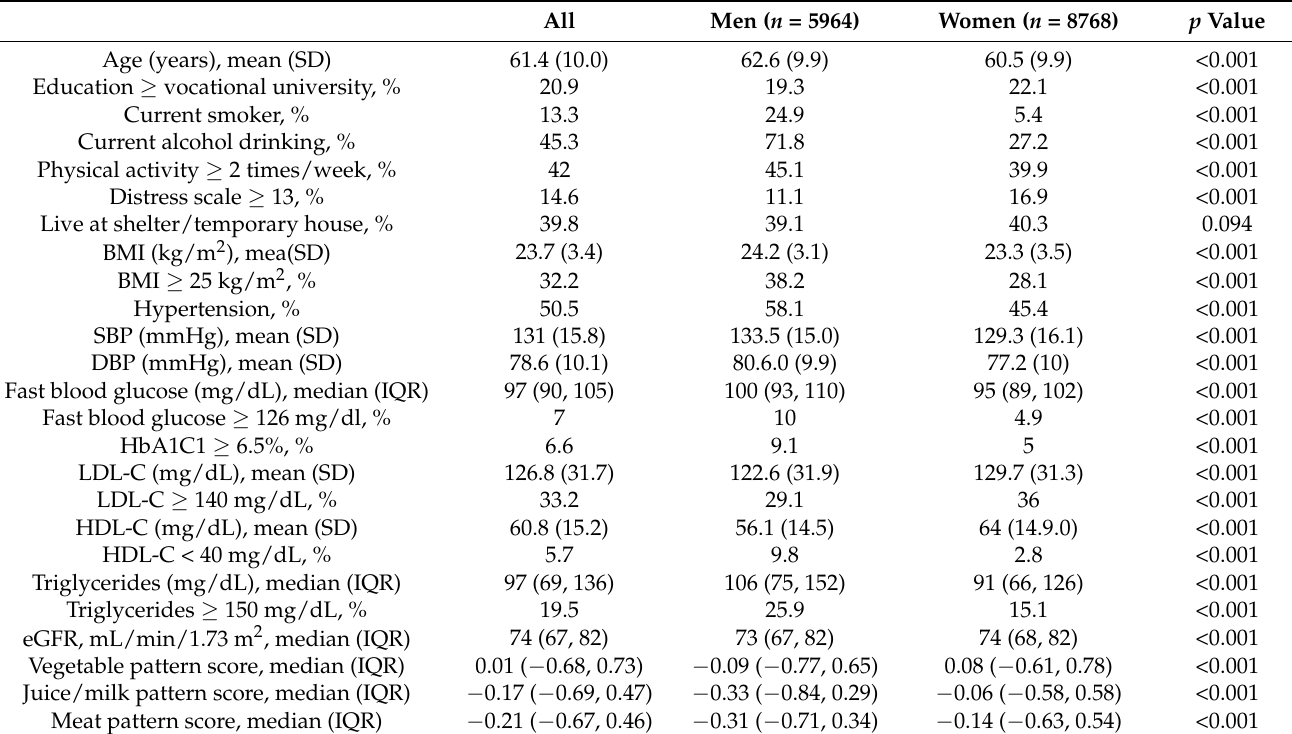
Table 2. Characteristics of participants at baseline in 2011, FHMS ( n =